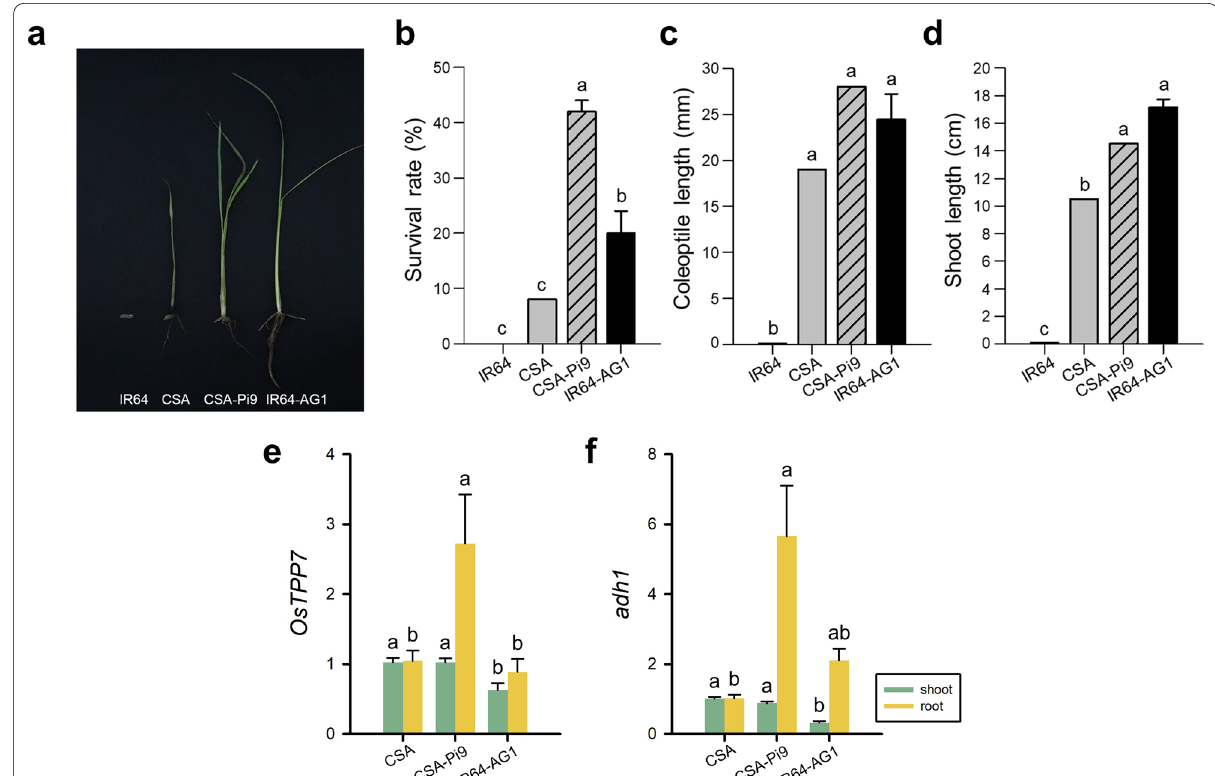
Fig. 5 Characterization of CSA‑Pi9 under anaerobic germination conditions. Phenotype of CSA‑Pi9 plants at 34 days after sowing ( a ), germination rate ( b ), coleoptile length ( c ) and shoot length ( d ). Expression levels of OsTPP7 ( e ) and adh1 ( f ). Data for IR64 were unavailable, as its seeds did not germinate. Lowercase letters above bars indicate statistically significant differences ( P < 0.01; Duncan’s multiple range